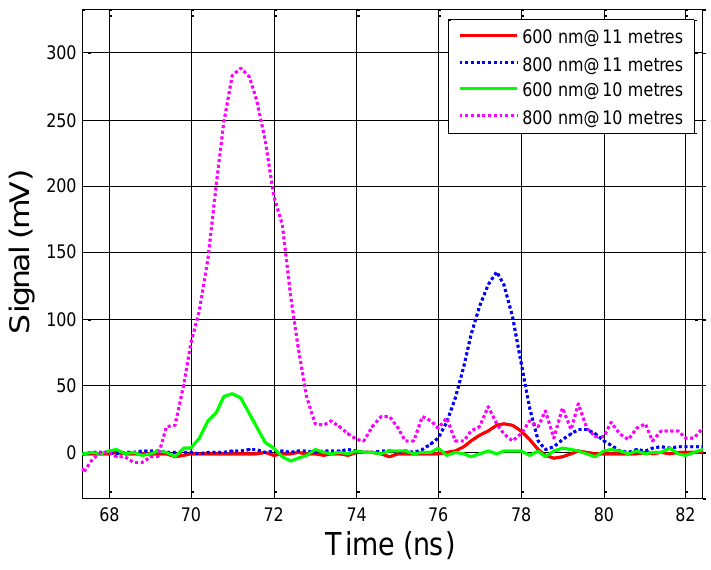
Figure 3. The echoes of two-channel hyperspectral LiDAR from the Spectralon reflection board at ranges of 10 and 11 meters,